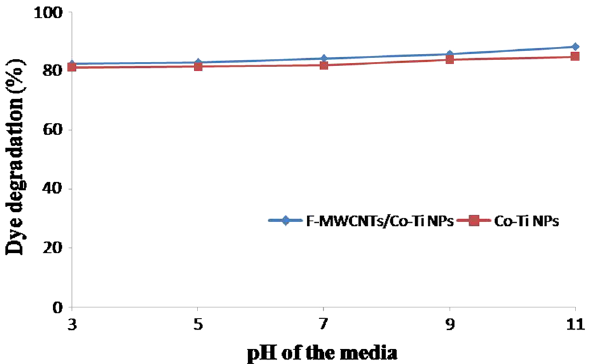
Fig. 13 Comparison of %degradation of RB dye photodegraded by A-MWCNTs/Co–Ti oxides and Co–Ti oxide NPs in different pH